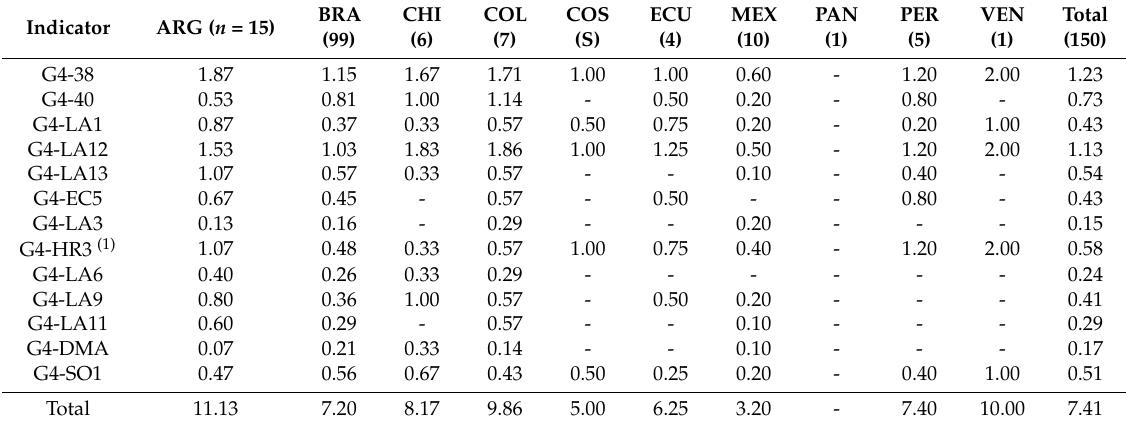
Table 3. Average of the social disclosure of gender information, by indicator, country, and total for Latin America.